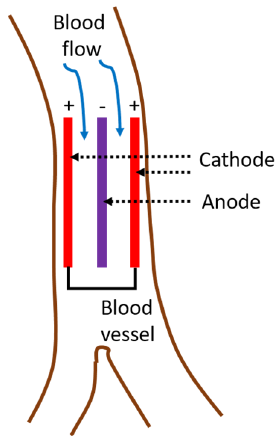
Figure 10. A futuristic concept of a biofuel cell for implementation within a blood vessel with enzyme immobilized electrodes, redrawn from the schematic shown in [258].